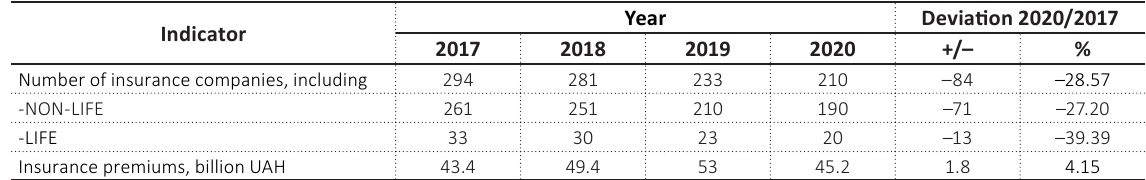
Table 7. Performance indicators of insurance companies in Ukraine in